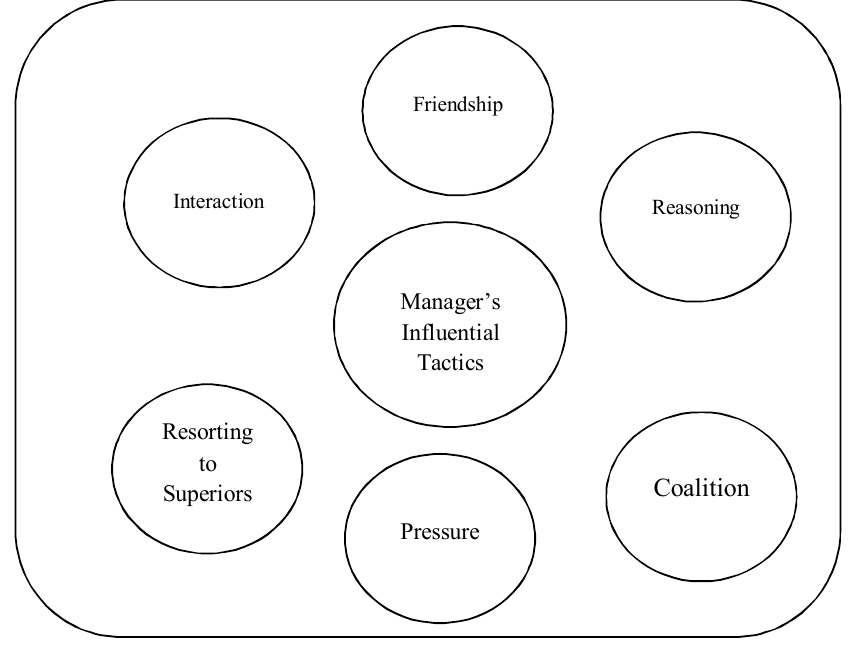
Fig. 1. Conceptual model of the